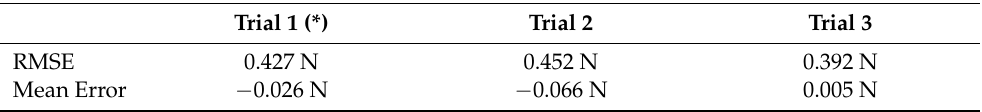
Table 4. RMSE and mean prediction error during palpation using the spring-based adaptor. Asterisks (*) denote presented